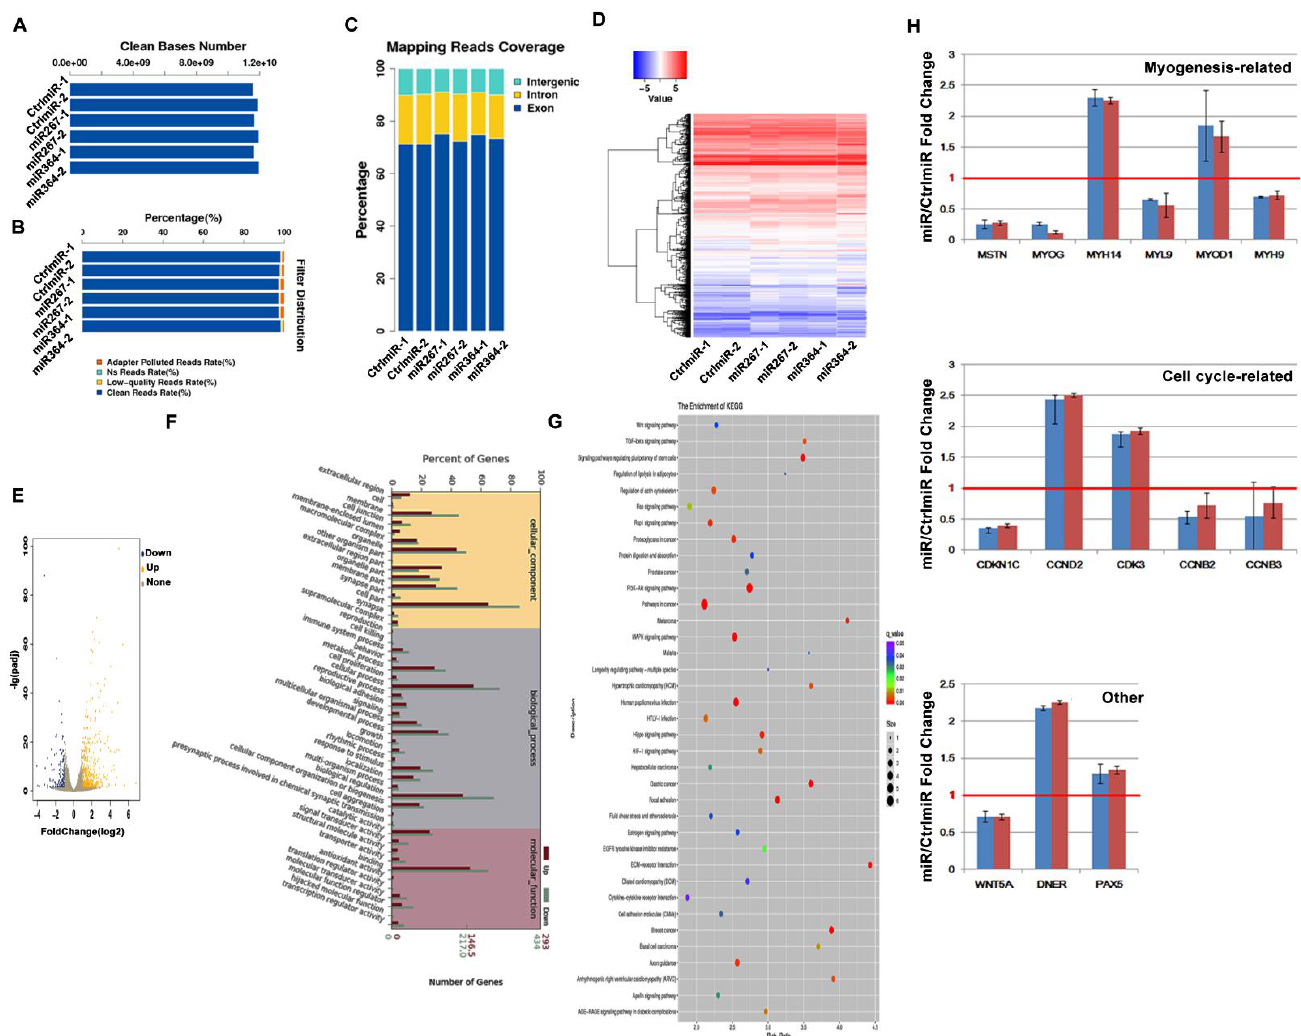
Figure 3. Analysis of differentially expressed genes (DEGs) after MSTN knockdown in HMSC. ( A ) Clean base number of all sample readings. ( B ) Filtering distribution map indicates the high quality of readings. ( C ) The location of readings indicates the normal distribution ratio of read sequences. ( D ) Clustering of DEGs among samples. ( E ) Volcano plot for the DEGs between control group and MSTN knockdown group. ( F ) Histogram of GO enrichment of DEGs. ( G ) KEGG pathway analysis on DEGs. ( H ) qPCR validation of DEGs. Red line represents the gene expression level in control group, and all bars represent the expression levels of tested genes in experimental groups treated with different miRNA targeting MSTN . All tested genes in experimental groups showed signifi- cant changes at p < 0.05 compared to the control group.